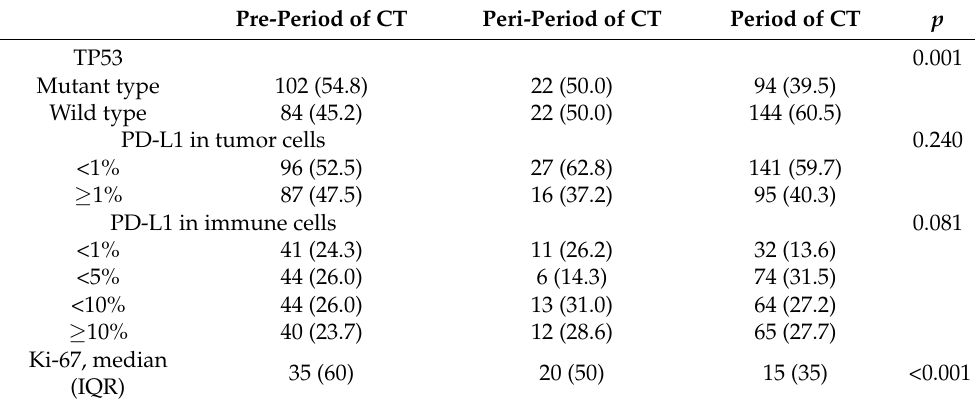
Table 4. The biomarker of lung cancer changed with CT examination.